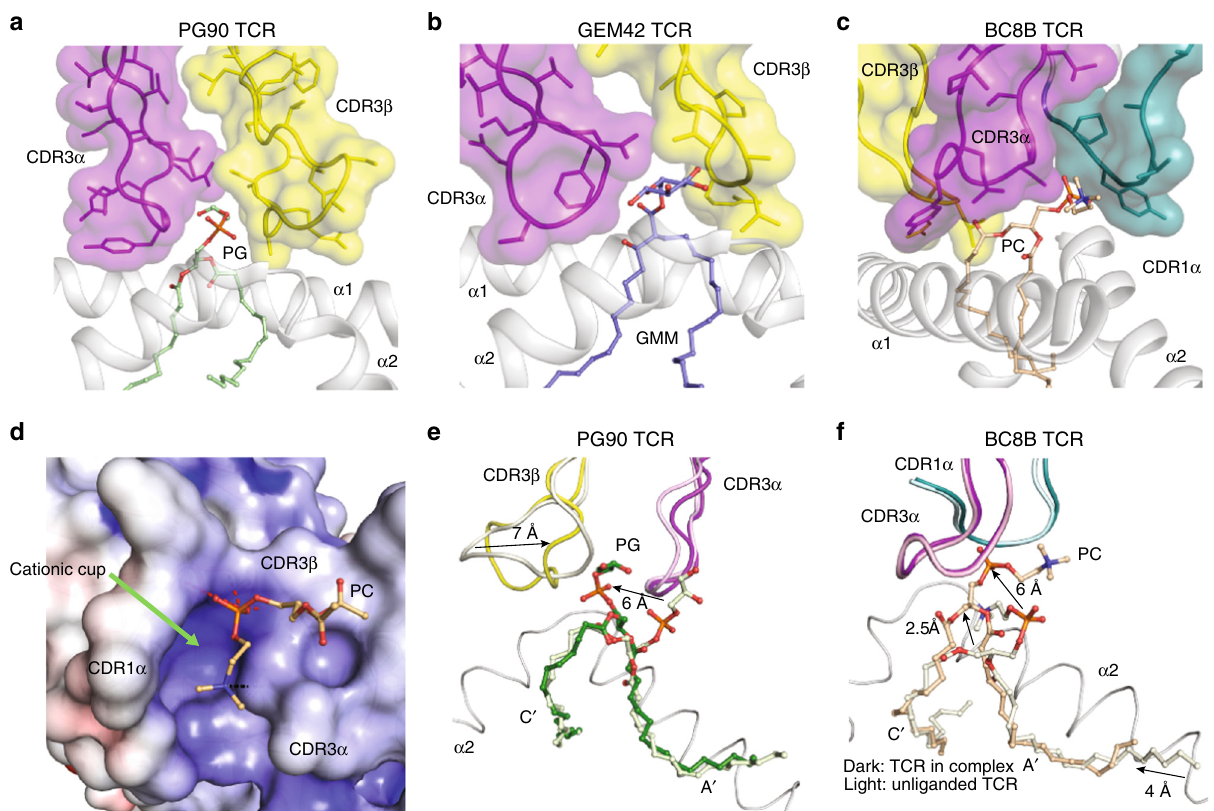
Fig. 5 Cationic cup formation and rearrangement upon TCR docking. a – c CDR loop contacts with antigen head group. Surface representation of the CDR1 α (teal), CDR3 α (purple), and CDR3 β (yellow) loops of a the PG90 TCR in contact with PG (green), b the GEM42 TCR in contact with GMM (blue), and c the BC8B TCR in contact with PC (light orange). d Electrostatic potential of the cationic cup (green arrow) formed by the BC8B TCR viewed bottom up from CD1b to the TCR. Hydrogen bonds and hydrophobic interactions between residues within the cationic cup and PC are indicated in red and black dashes, respectively. The potential contours are shown on a scale from + 10.0 (positive charge, blue) to − 10.0 k B T e − 1 (negative charge, red); white indicates a value close to 0 k B T e − 1 (neutral charge). Cationic cup and direction of lateral escape are indicated by green and black arrows, respectively. b Cationic cup and lipid antigen remodeling upon docking of e the PG90 TCR, and f the BC8B TCR. CDR loops of the unliganded TCR and TCR in complex with CD1b, as well as lipid antigens presented in CD1b binary and in complex with TCR structures, are represented in lighter and darker colors, respectively, as per Fig. 4a. Directions of movement are indicated by black